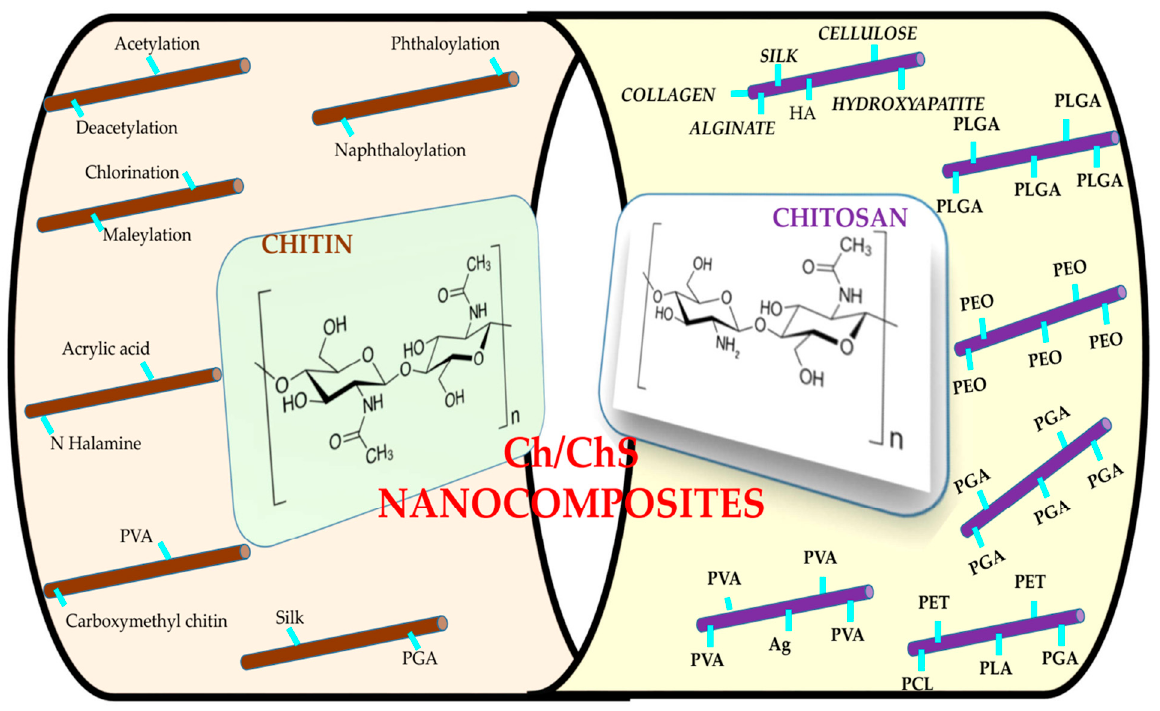
Figure 4. Snapshot of the existing Ch/ChS based nanocomposites.